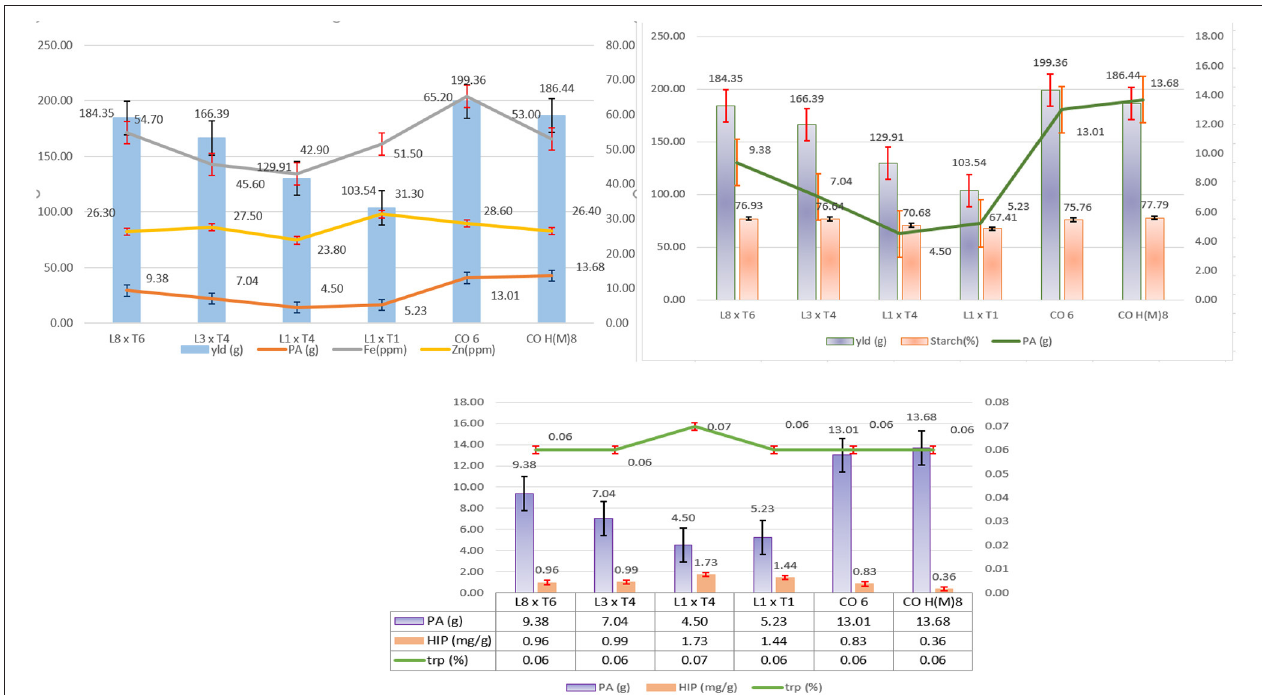
FIGURE 11 | The overall performance of the selected and identified hybrids with standard checks CO 6 and CO H(M) 8 for single plant yield (g), PA (mg/g), iron (ppm), zinc (ppm) starch (%), HIP (mg/g), and tryptophan (%). Comparative performances of yield with PA, HIP, tryptophan, iron zinc, and starch are depicted.